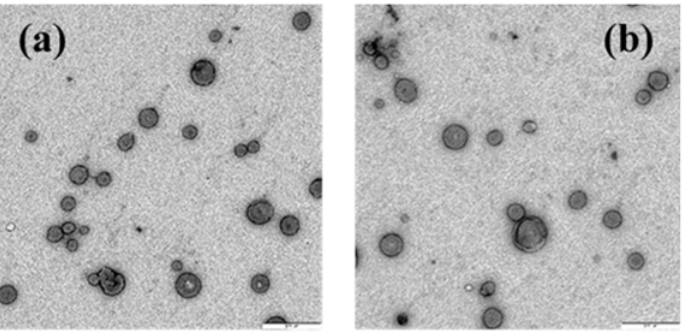
Figure 8. TEM images, obtained by negative staining, of: ( a ) liposomes at α = 0.7, and ( b ) lipoplexes at α = 0.7 and L/D = 8 (Scale bar = 0.5 µm).